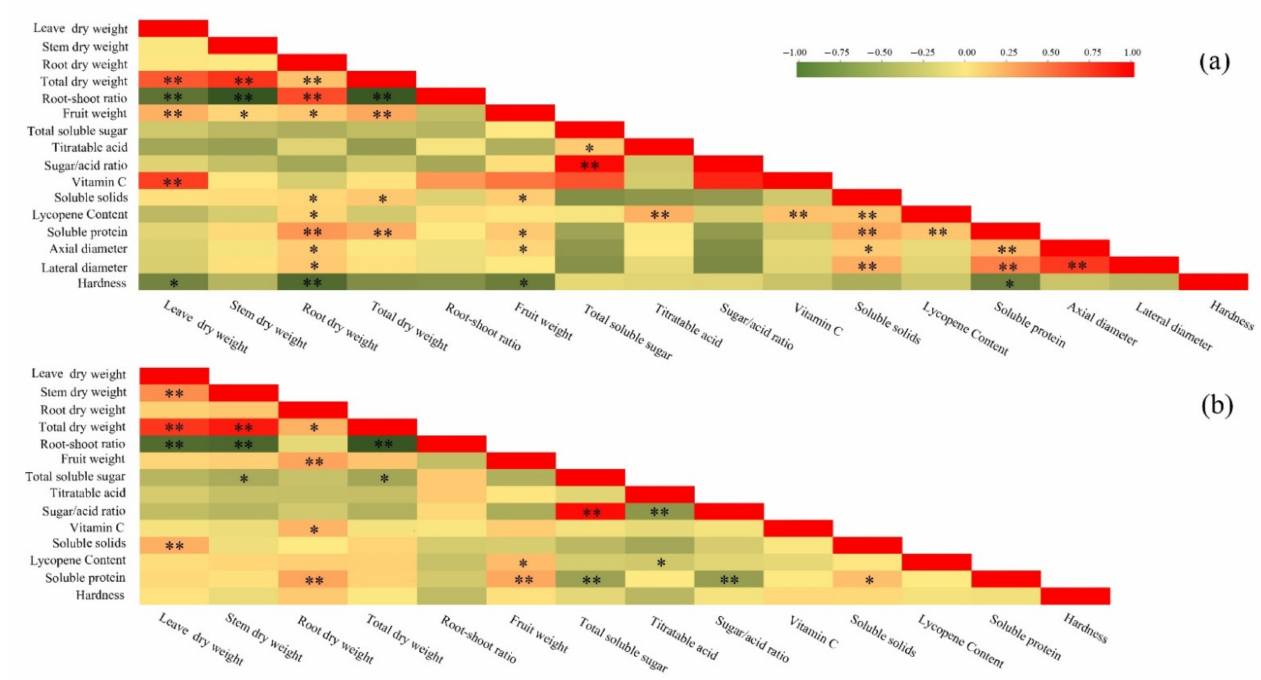
Figure 3. Pearson correlation between growth and quality parameters of tomato during spring ( a ) and autumn ( b ) under soil aeration and plastic film mulch treatments. * Significant at the 5%; ** Significant at the 1%